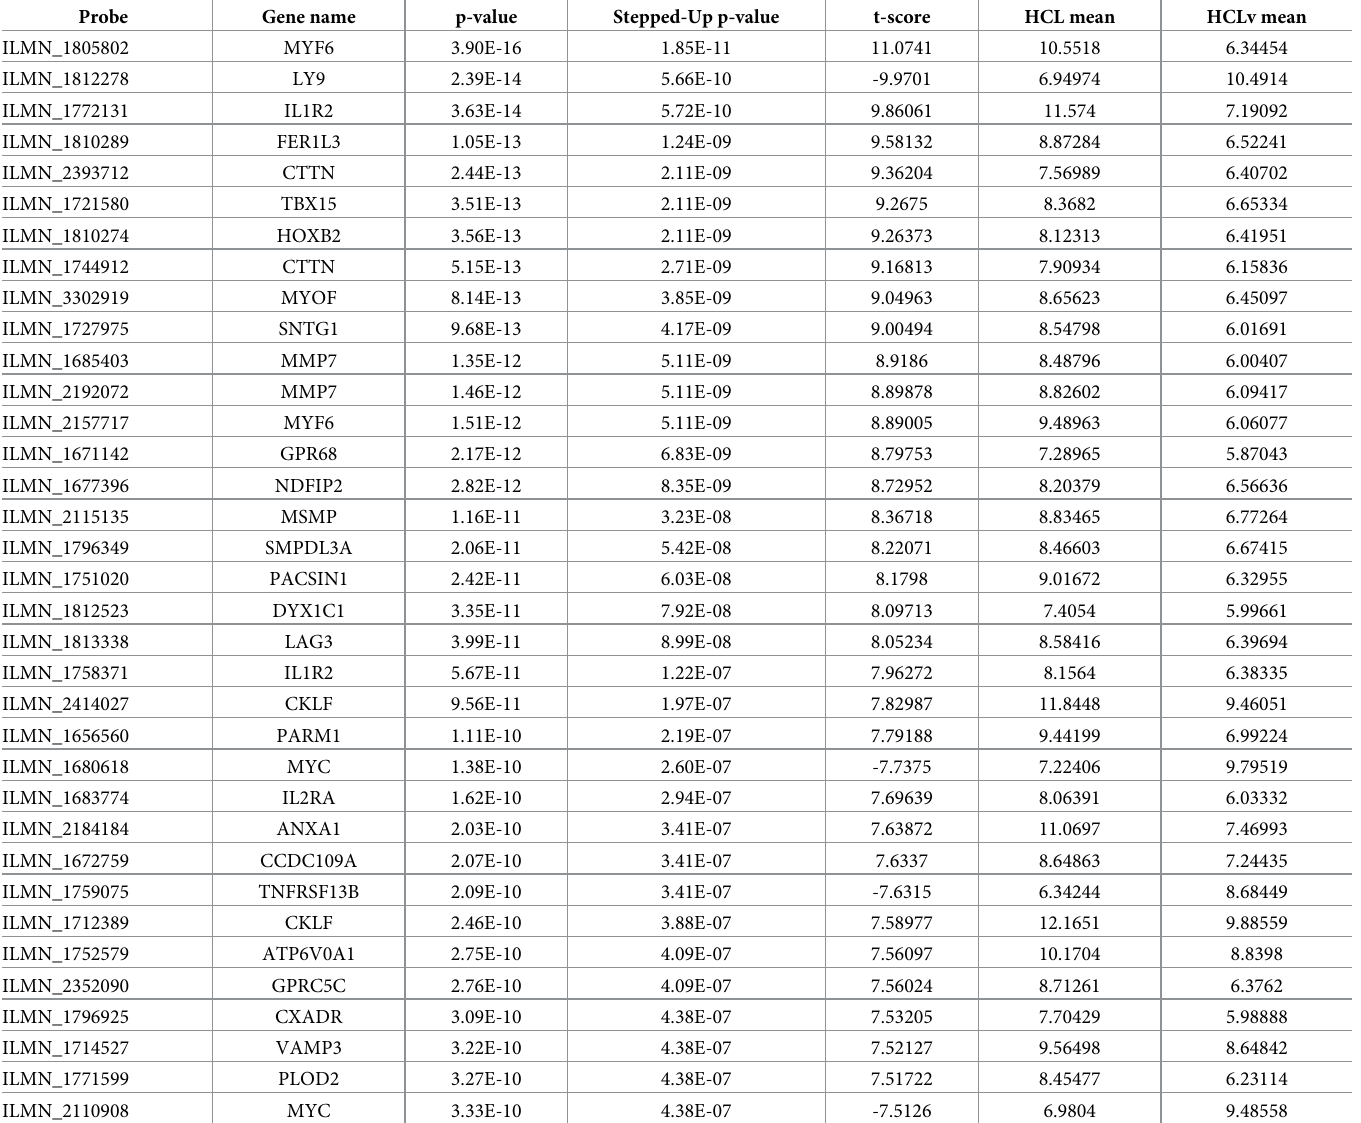
Table 3. Microarray data for probes with absolute T-score > 7.5 with mean log 2 values.